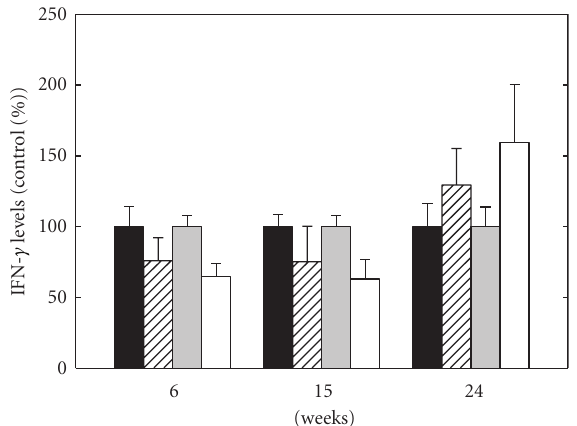
Figure 4: Secreted IFN- γ levels of adjuvant mice (black bars) and eAPS mice (upward diagonal bars) versus cytosolic IFN- γ levels of adjuvant mice (grey bars) and eAPS mice (white bars). The average of IFN- γ level of the adjuvant control group was defined as 100%, and the results expressed as percentage of control group at the same time point. Results are presented as the mean ± SEM.